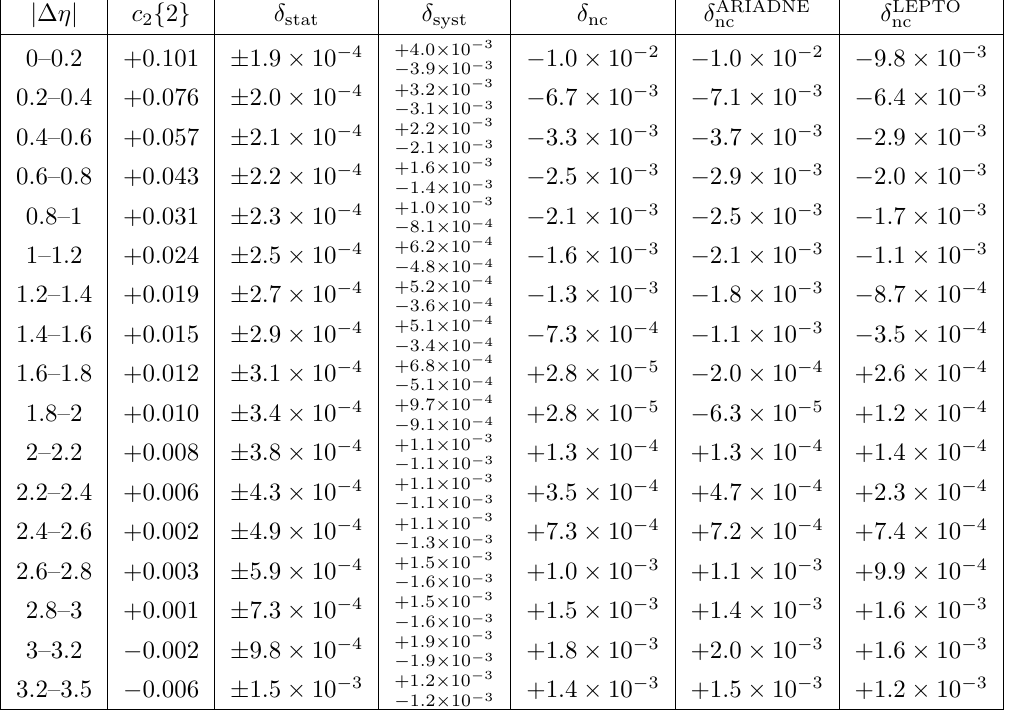
Table 15 . c 2 f 2 g versus j (cid:1) (cid:17) j from (cid:12)gure 8 (b) and (cid:12)gure 12 (a), p T > 0 : 1 GeV; (cid:14) stat , (cid:14) syst and (cid:14) nc denote the statistical, systematic and Monte Carlo non-closure uncertainties,